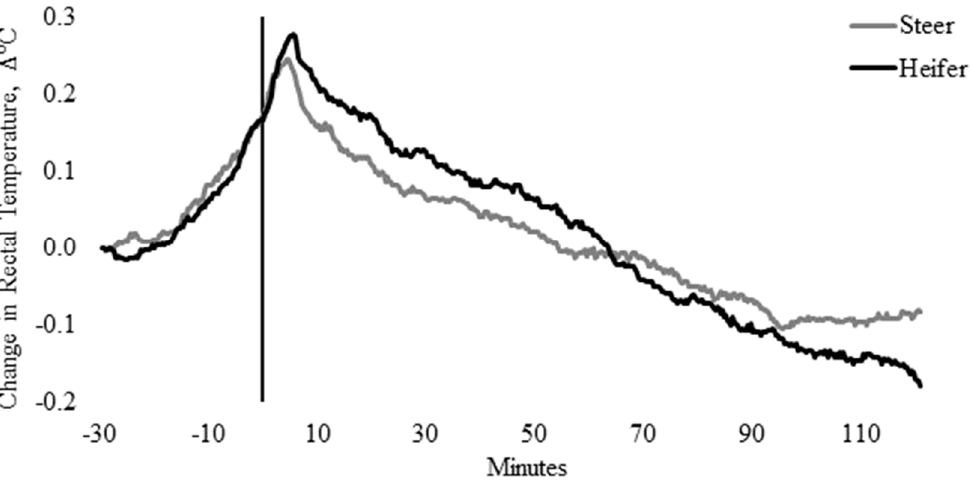
Figure 2. Change in twenty-seconds rectal temperature ( ± SEM) from baseline rectal temperature (T REC , °C) for heifers (solid black line) and steers (solid gray line), 30 min prior to 2 h post-handling, also showing the time from weighing box (solid black vertical line).